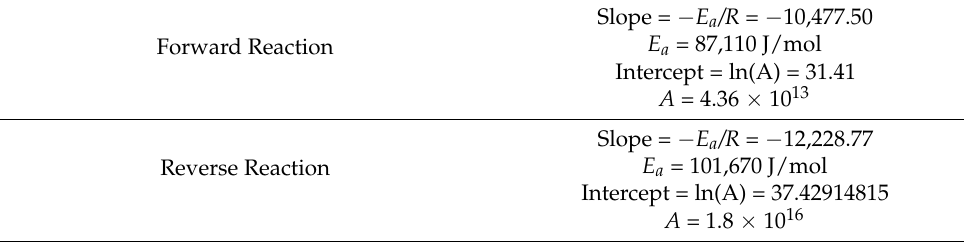
Figure 12. Plot between ln K and 1/T for forward and backward reactions. From Figure 12, the Arrhenius parameters found for forward and backward reactions are presented in Table 10. Table 10. Activation energy of forward and reverse